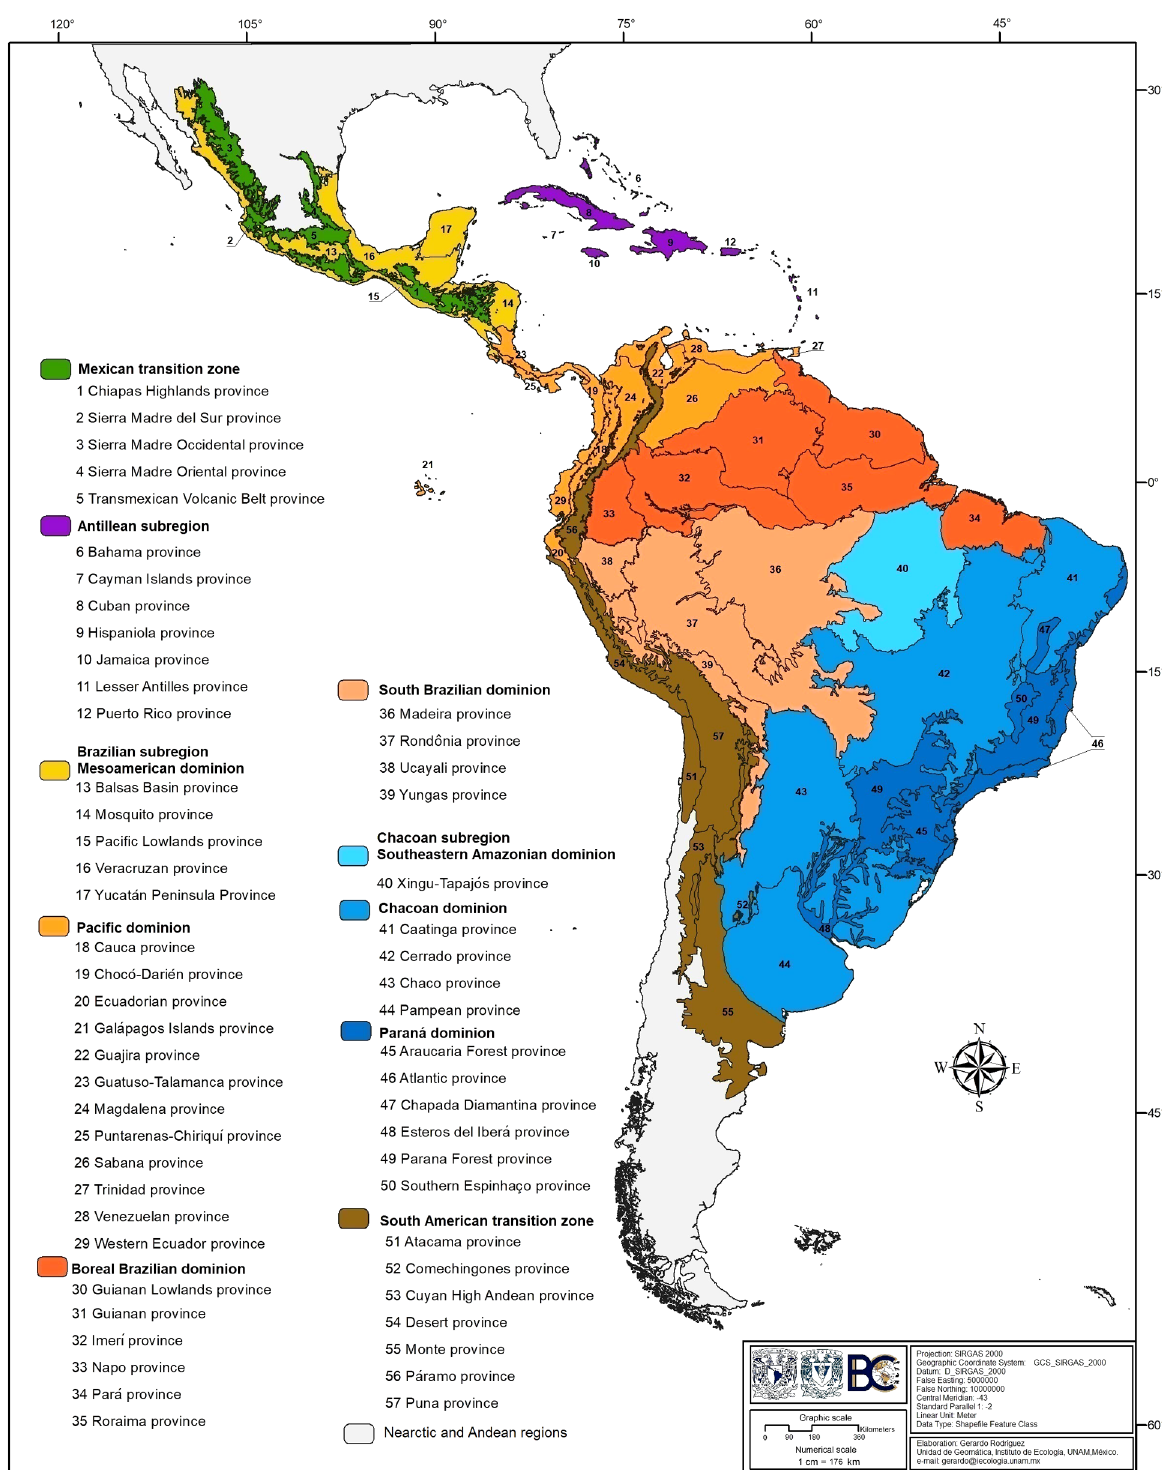
Figure 1. Biogeographic provinces of the Neotropical